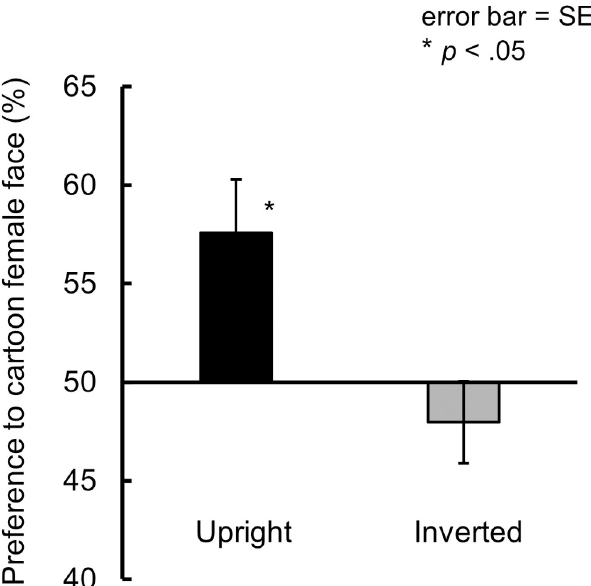
Fig 2. Preference scores for cartoon female face (vs. cartoon character face) in upright and inverted conditions (Experiment 1). A preference for a cartoon female face indicates above chance (50%), and a preference for cartoon character face indicates below chance. Error bars represent standard